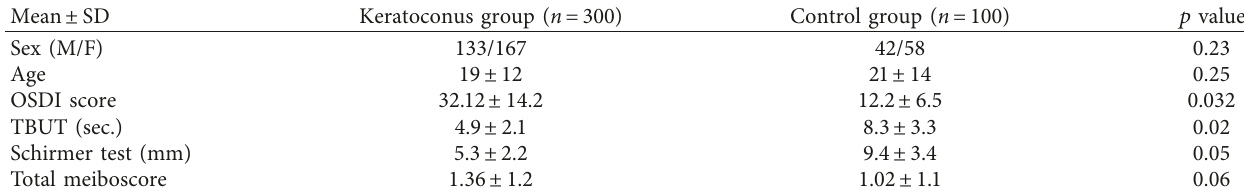
Table 1: Clinical findings of both groups.